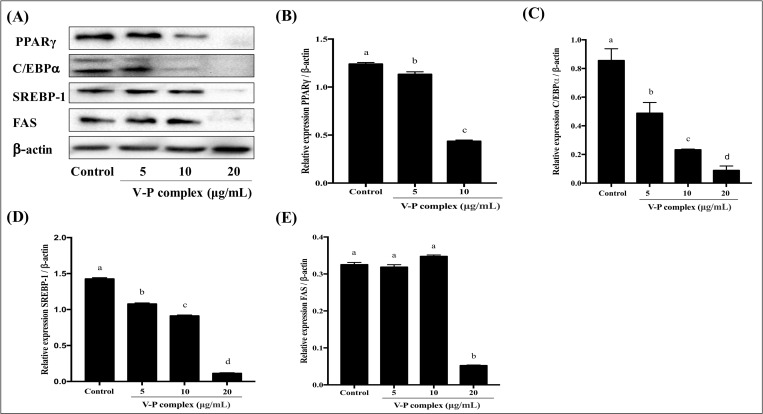
Effect of V-P complex on protein expression of adipocytes-related specific genes.a, b, c, d Different letters indicate a significant difference (p< 0.05) within the graph.